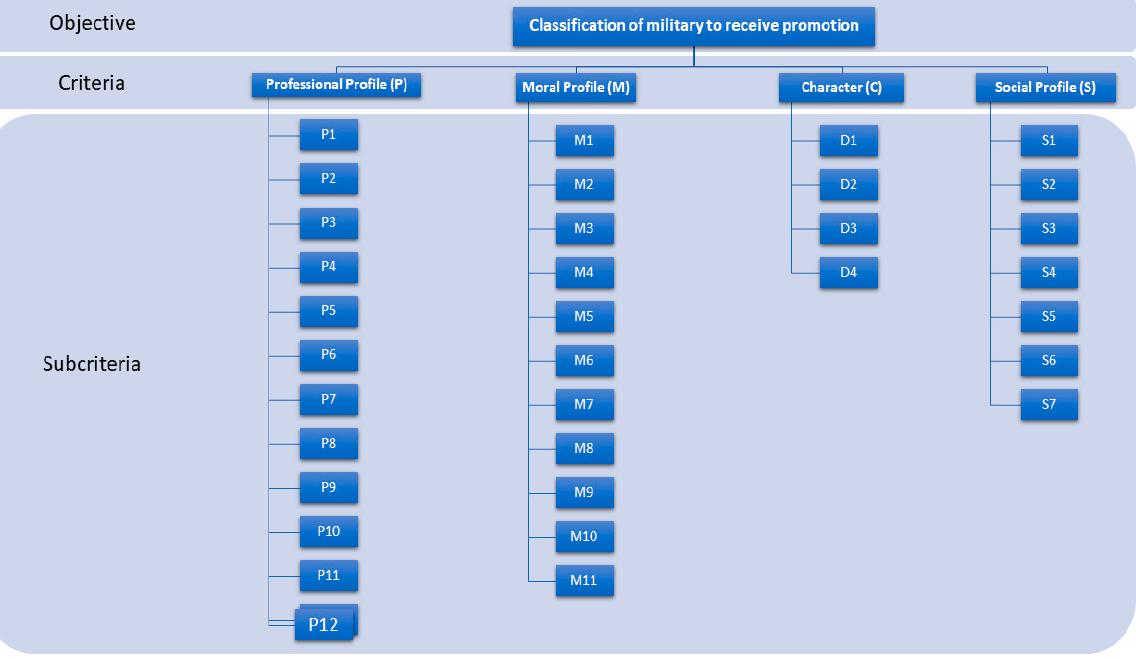
Figure 9. The hierarchical structure of the